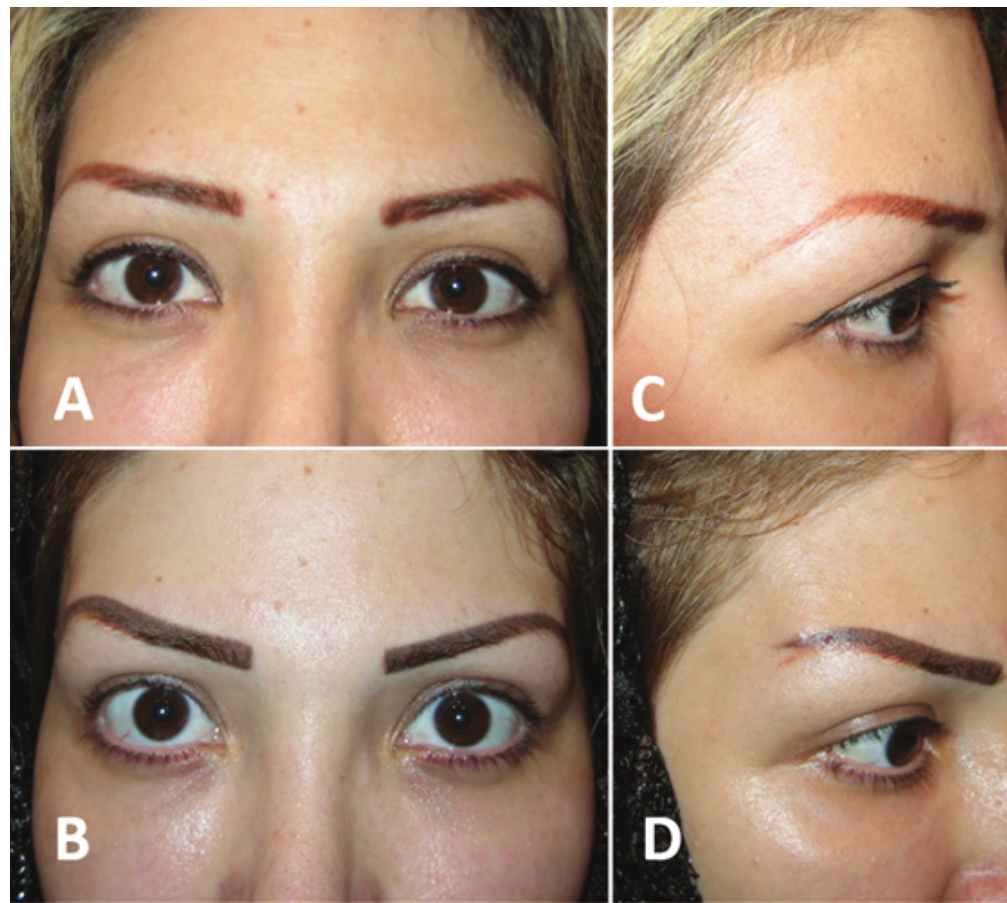
Figure 7. While suture (barbed) lift minimally elevates the eyebrow tail and consequently increased eyelid show (B & D), the effect is temporary. It is usually performed in young females (A & C) with realistic